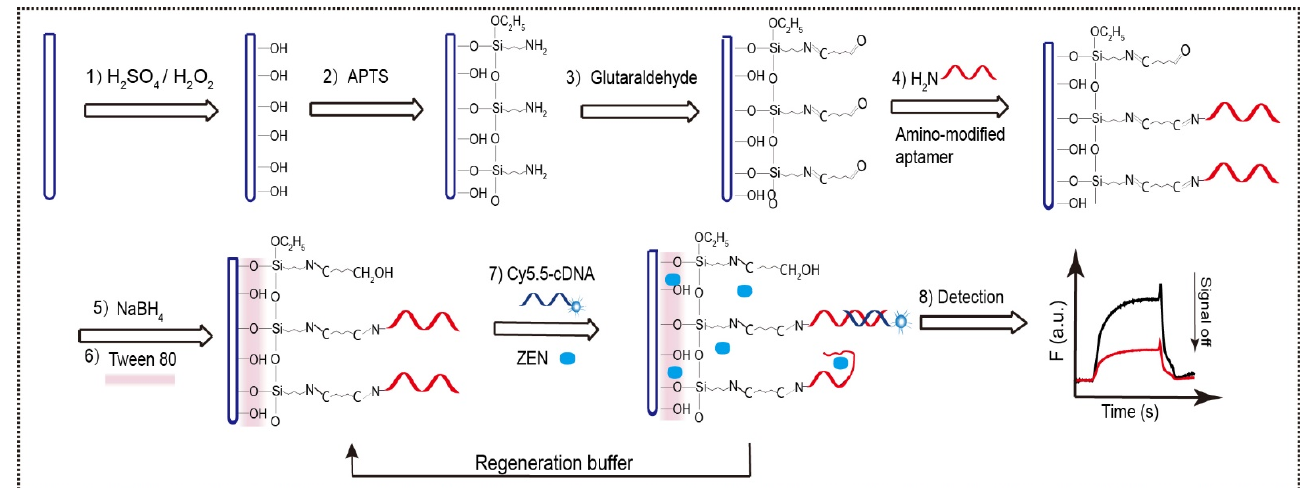
Figure 2. The fabrication and detection process of NADL-EWOF including ( 1 ) oxidation by piranha, ( 2 ) salinization, ( 3 ) linker-coupling to transform the amino group into aldehyde groups, ( 4 ) coupling of aptamer, ( 5 ) reduction by NaBH 4 , ( 6 ) coating with Tween 80, ( 7 ) injection of the mixture containing Cy5.5-cDNA and ZEN, and ( 8 ) detection and data analysis.